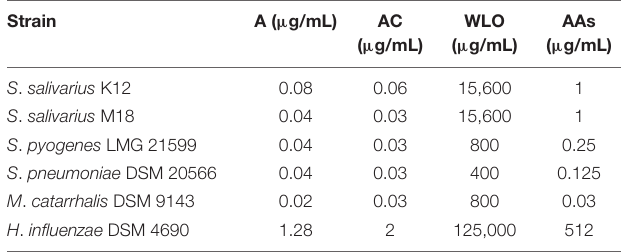
TABLE 4 | MBC values obtained for all tested